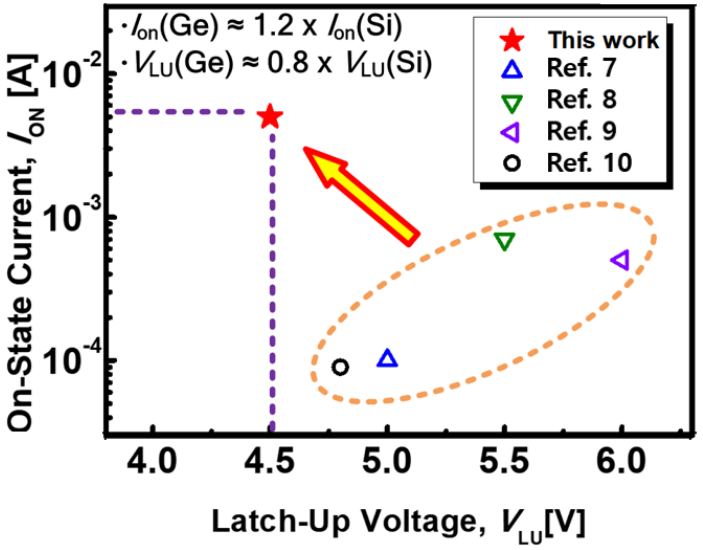
Figure 6. 2-D SILVACO device simulation data showing e-field near the collector region of the Si and Ge biristor.